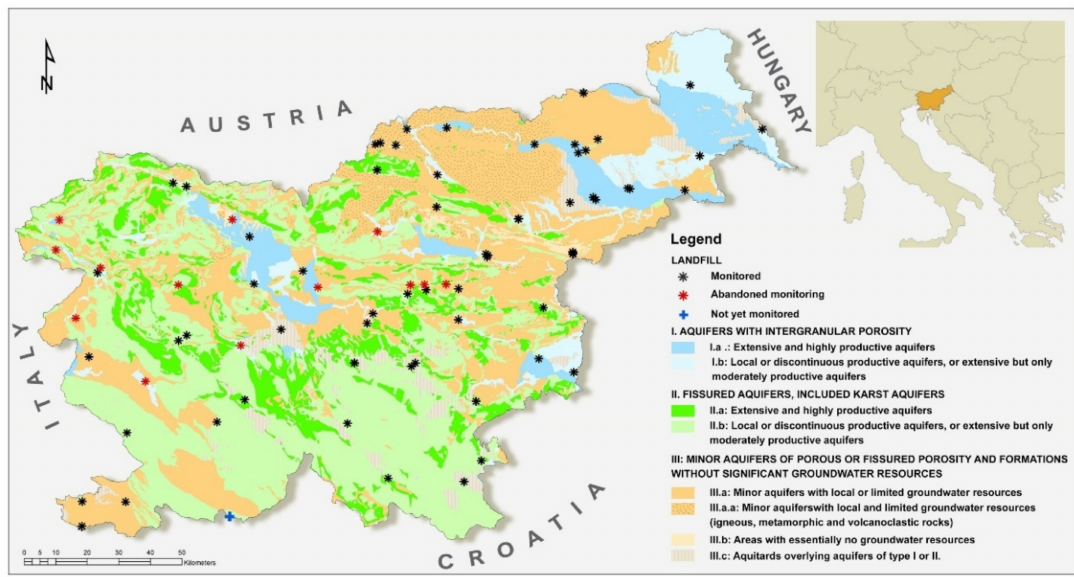
Figure 1. Study area and landfill